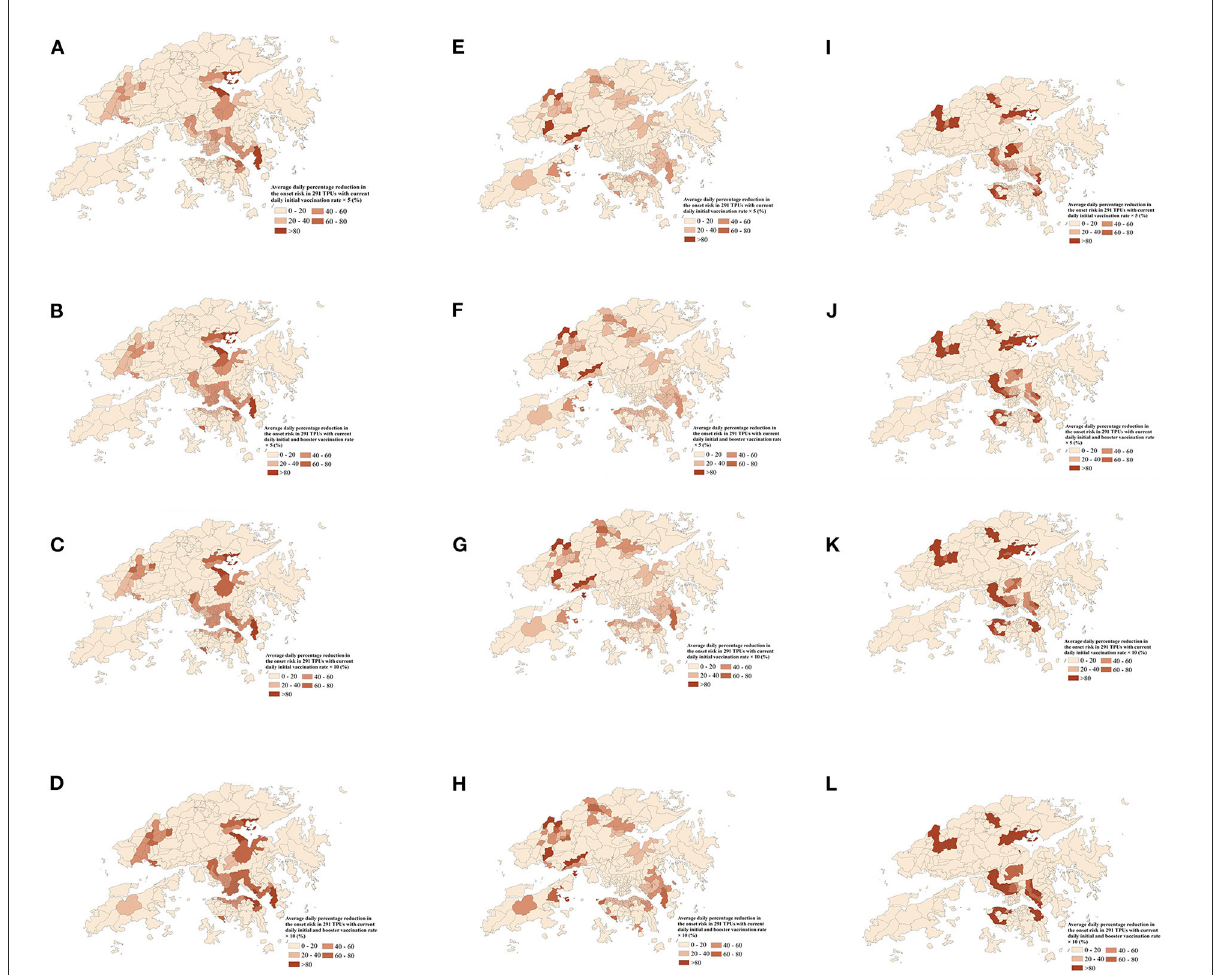
FIGURE8 The average daily percentage reduction in the symptom onset risk in 291 TPUs of Hong Kong with 5 times or 10 times the current daily full and booster vaccination rate, compared with the current daily full and booster vaccination rate. (A-D) indicates the average daily percentage reduction in the symptom onset risk of Omicron BA.1 in 291 TPUs. (E-H) indicates the average daily percentage reduction in the symptom onset risk of Omicron BA.2 in 291 TPUs. (I-L) indicates the average daily percentage reduction in the symptom onset risk of Delta AY.127 in 291 TPUs. (A) Average daily percentage reduction in the onset risk in 291 TPUs with 5 times current daily full vaccination rate—Omicron BA.1. (B) Average daily percentage reduction in the onset risk in 291 TPUs with 5 times current daily full and booster vaccination rate—Omicron BA.1. (C) Average daily percentage reduction in the onset risk in 291 TPUs with 10 times current daily full vaccination rate—Omicron BA.1. (D) Average daily percentage reduction in the onset risk in 291 TPUs with 10 times current daily full and booster vaccination rate—Omicron BA.1. (E) Average daily